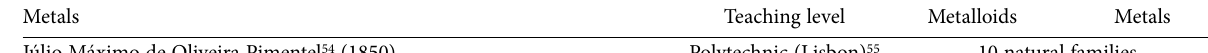
Table 3. Classification of elements in Portuguese textbooks from 1850 to